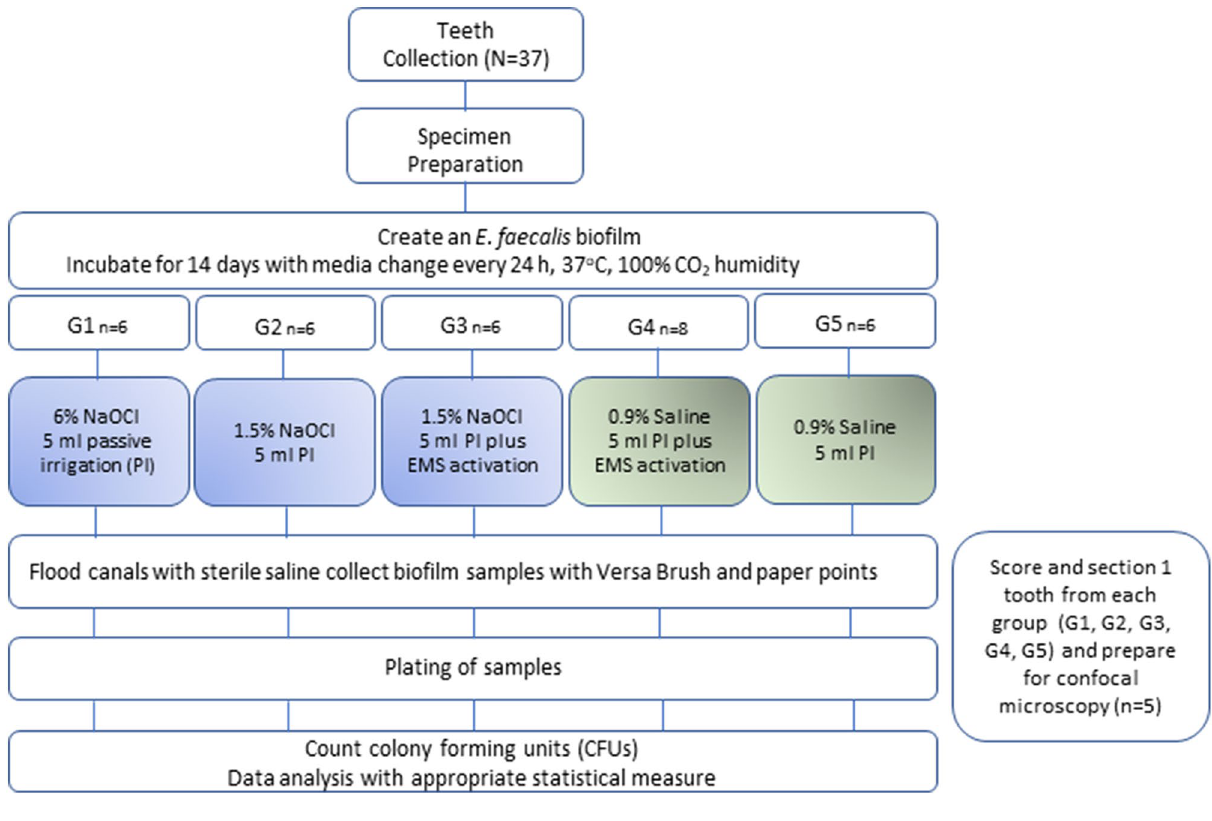
Figure 1. Experimental